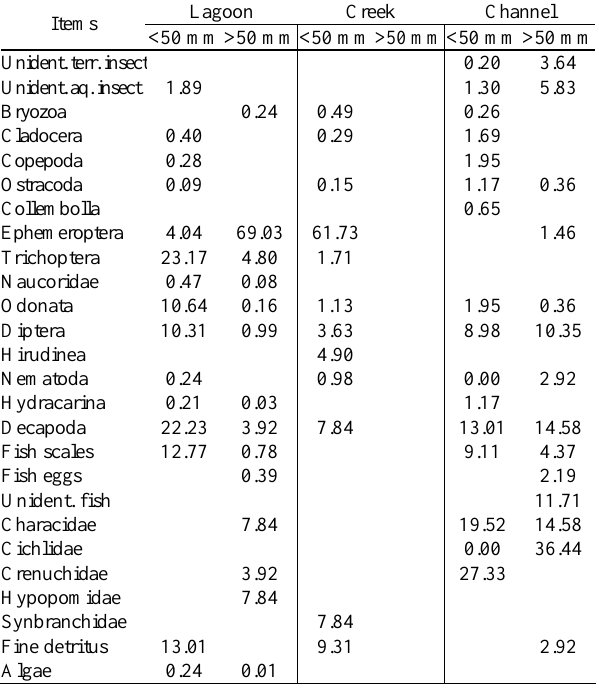
Table 2. Volumetric percentages of dominant food resource categories consumed by size classes of C . aff. wallacii in three habitats of Cinaruco River. Number of stomachs with